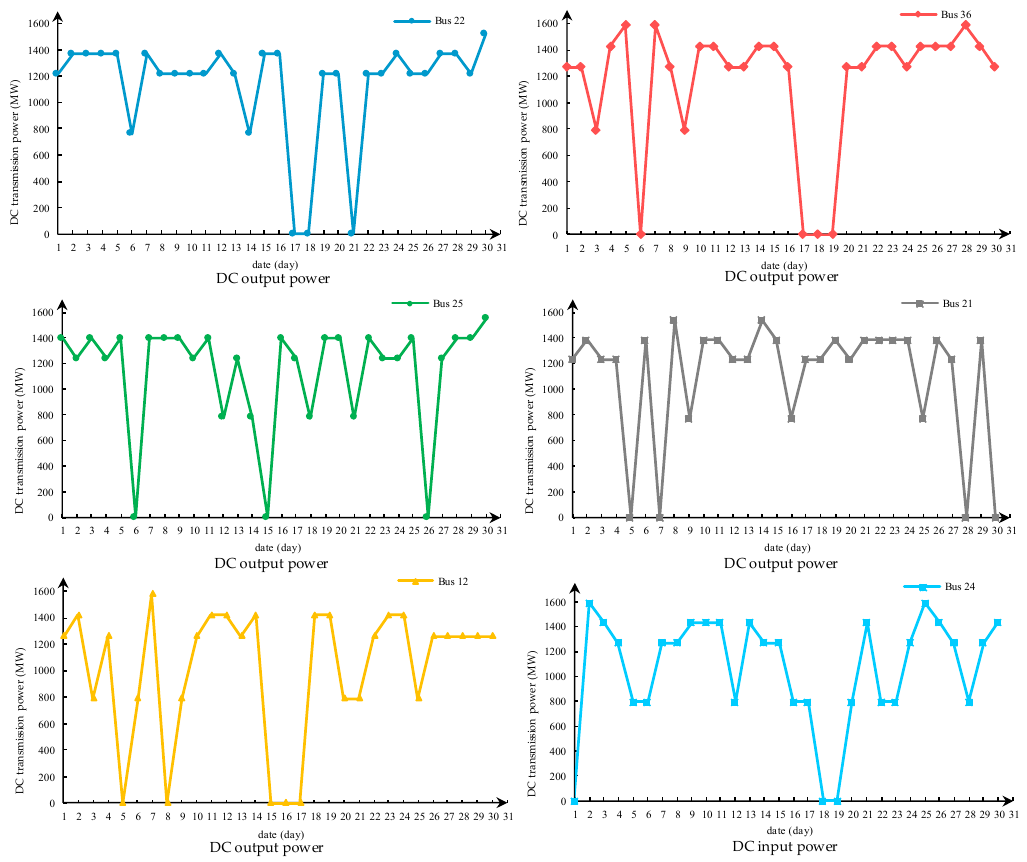
Figure 13. DC transmission power in Hubei Province.